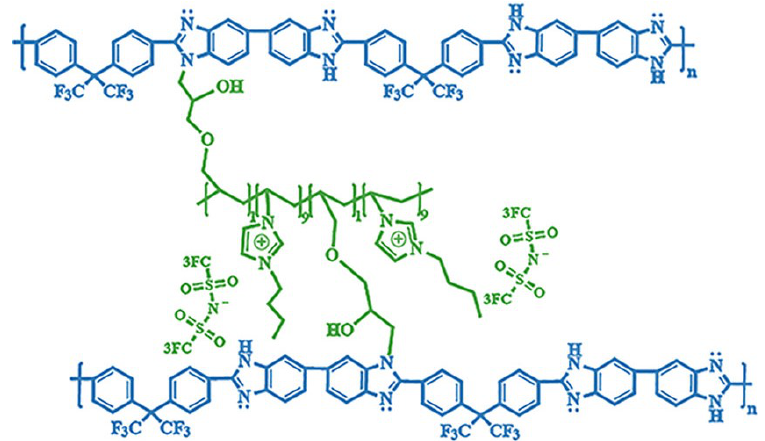
Figure 7. The cross-linked structure of 6FPBI-cPIL (taken from Ref. [71]). Lee et al. prepared new cross-linked ABPBI membranes via a direct casting process